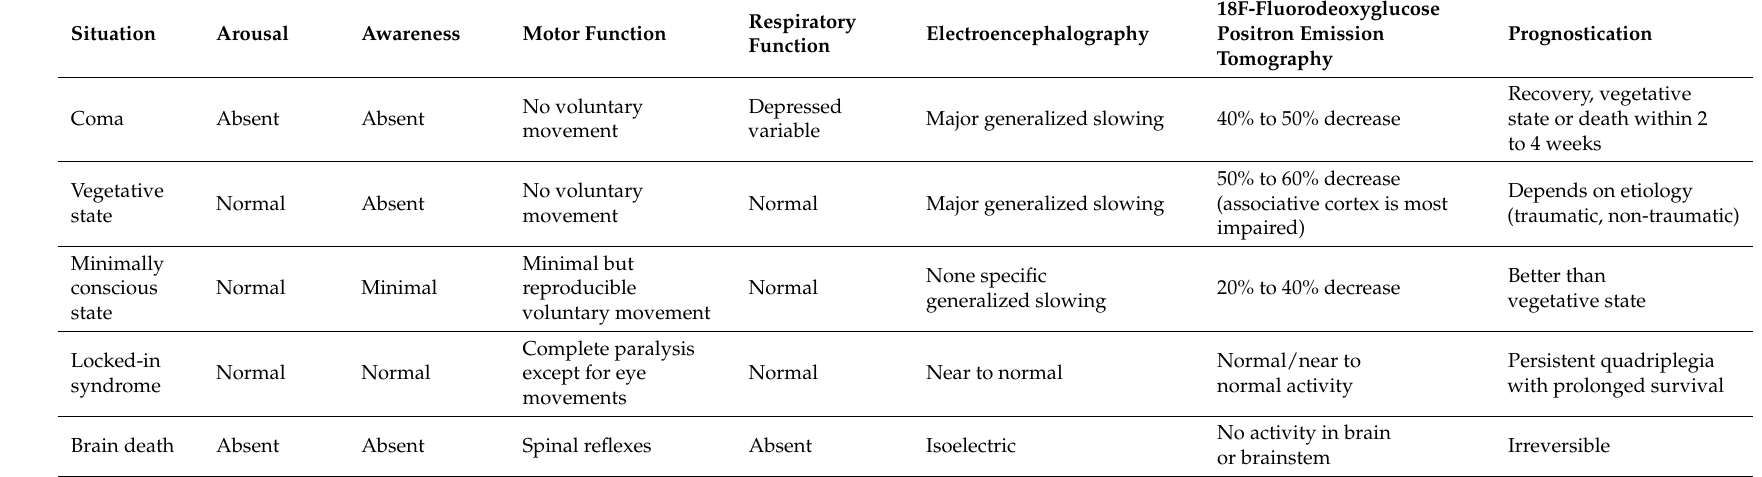
Table 2. The characteristics of patients in different situations after acute brain injury including coma, vegetative state, brain death, and related disorders